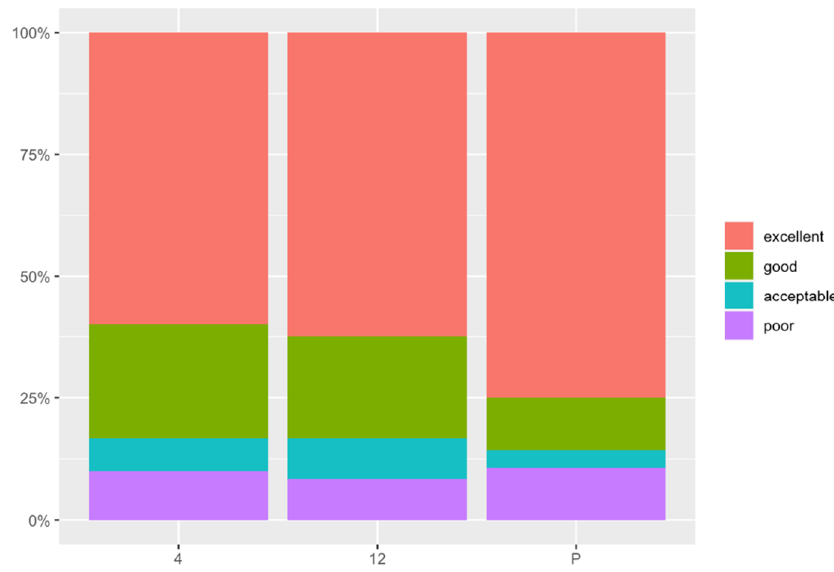
Figure 2. Degree of owner satisfaction at 4 and 12 months after surgery and at the end of the study (Question K). The X axis represents the time in months (4: four months after surgery; 12: twelve months after surgery; P: present). The Y axis represent the score, 0: poor and 10: excellent. The results obtained from the question of whether the owners would repeat the sur- gery in a similar situation were that 74.1% would repeat the surgery, 18.5% would not, and 7.4% remained doubtful (Figure 3).